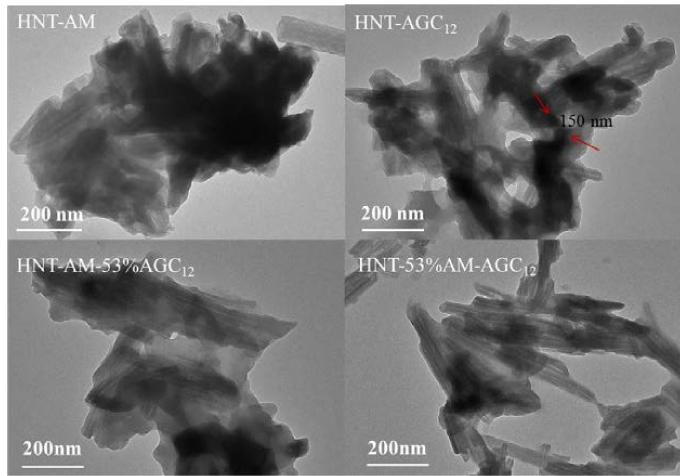
Figure 4. TEM images of grafted HNTs with different